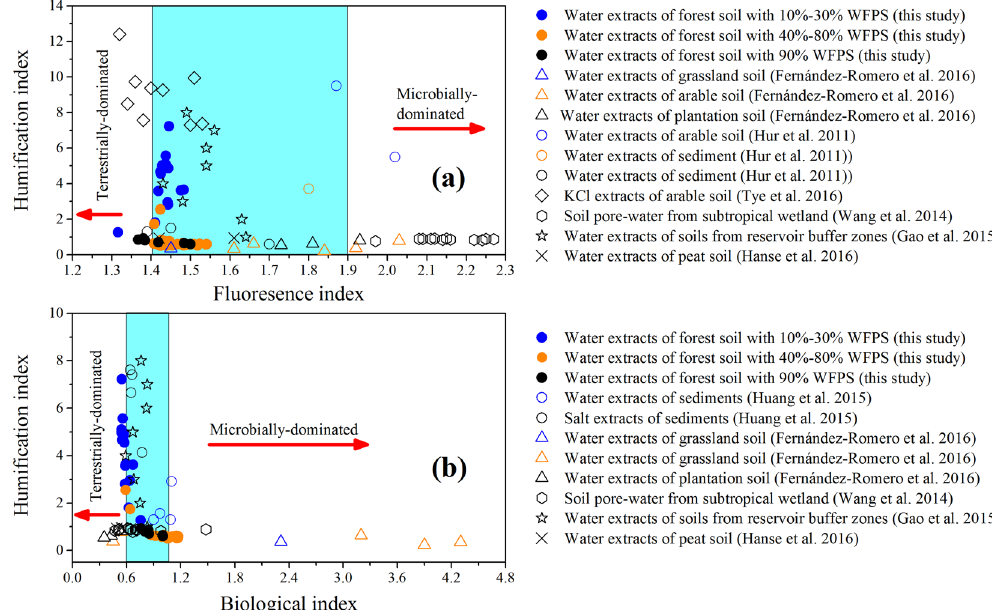
Figure 6. Comparison plots of humification index versus ( a ) fluorescence index and ( b ) biological index for water extracts of forest soils during thaw, together with different DOM data refering to results from Fernández- Romero et al . 62 , Hur et al . 63 , Tye et al . 64 , Wang et al . 65 , Gao et al . 66 , Hansen et al . 46 , and Huang et al . 67 . The shaded regions represent a mixed source of